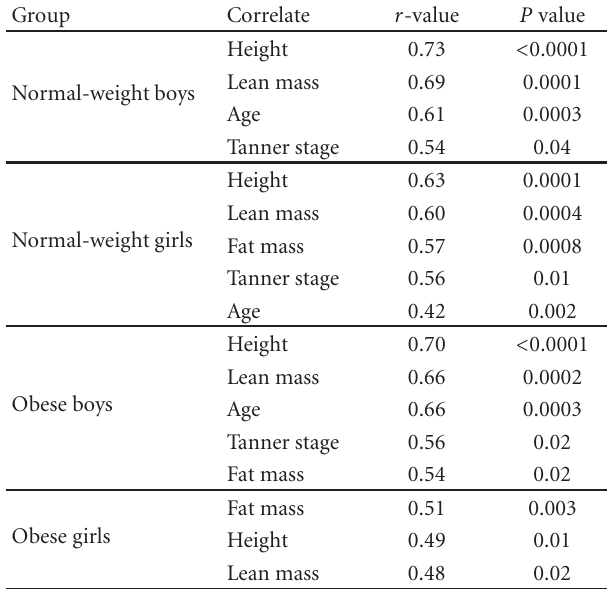
Table 3: Univariable correlations with